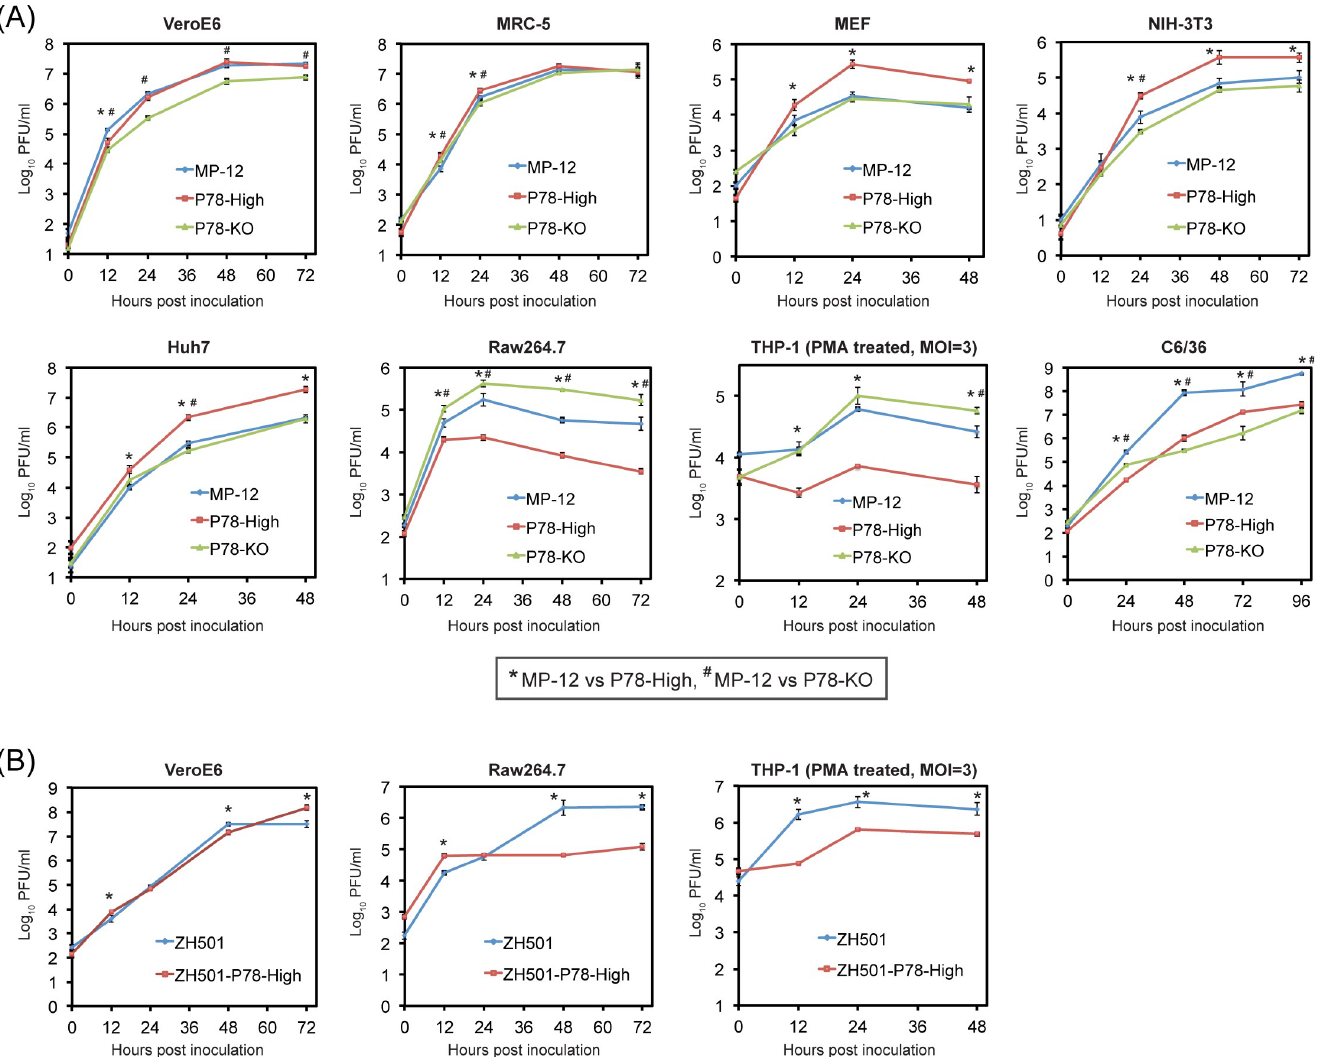
Fig 3. Growth kinetics of MP-12, P78-High virus, and P78-KO virus (A) and ZH501 and ZH501-P78-High (B) in different cell lines. Each of these viruses was inoculated into the indicated cell lines at an MOI of 0.01, except that viruses were inoculated at an MOI of 3 into THP-1 cells. Culture supernatant was collected at the indicated time points and infectivity determined by plaque assay in Vero E6 cells. The difference in virus titers between the parental virus and its variants was assessed by unpaired t-test at each time point. The data represents the mean values ± standard deviation from three independent experiments. Statistically significant differences (P < 0.05) in virus titers between MP-12 and P78-High virus and between ZH501 and ZH501-P78-High virus are indicated by � and those in virus titers between MP-12 and P78-KO virus are indicated by #